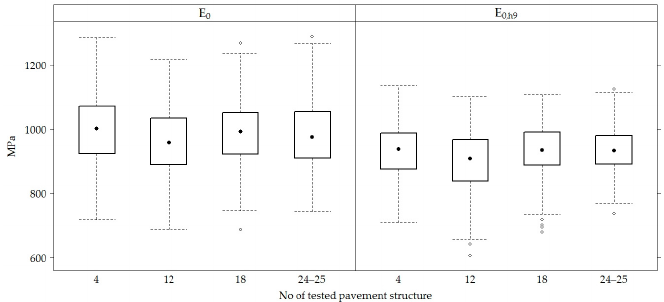
Figure 9. The box-plots of E 0 and E 0,h9 values in each tested road section.